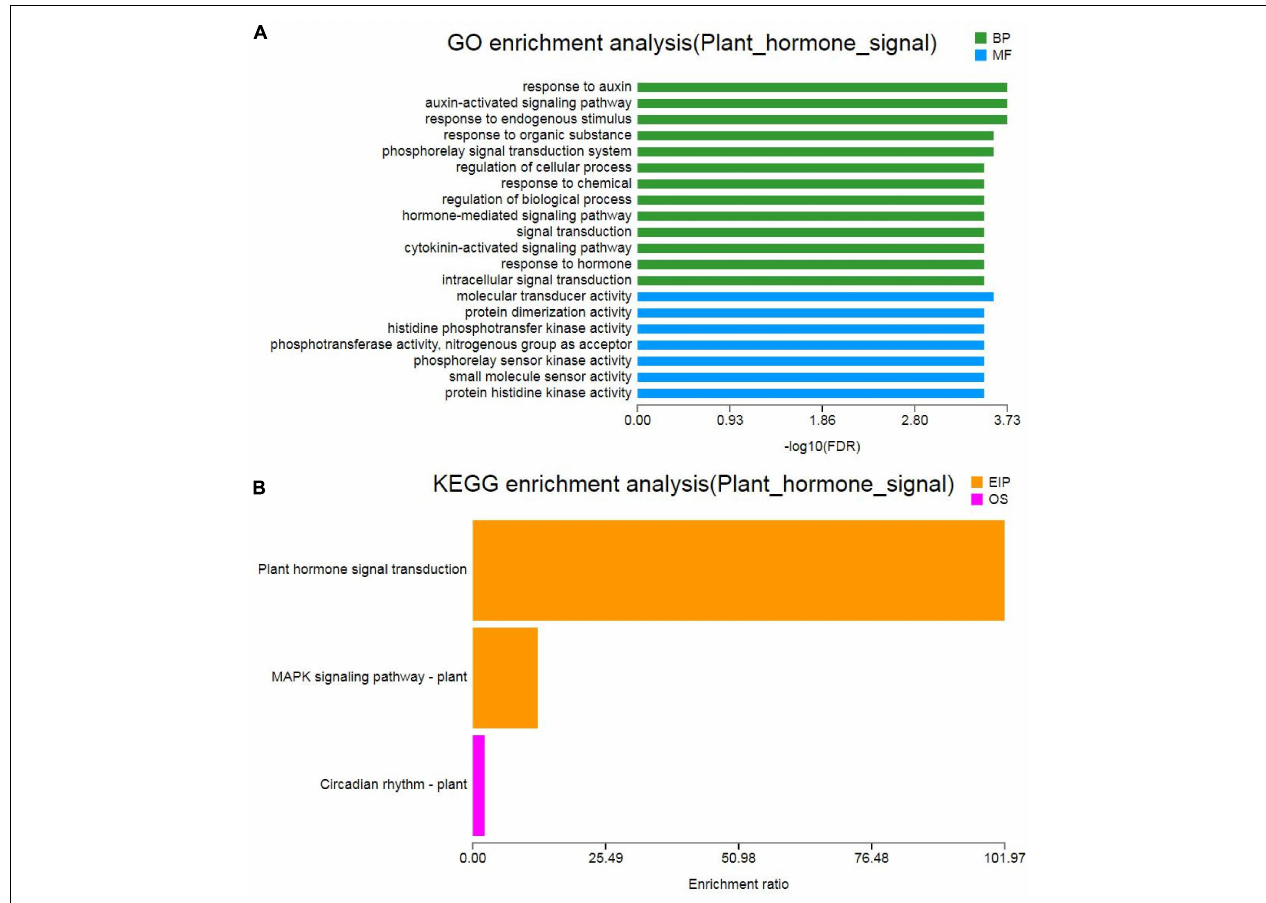
FIGURE 7 | Gene Ontology and KEGG analysis of the “plant hormone signal transduction” pathway. (A) GO analysis of the “plant hormone signal transduction” pathway. (B) KEGG analysis of the “plant hormone signal transduction” pathway.